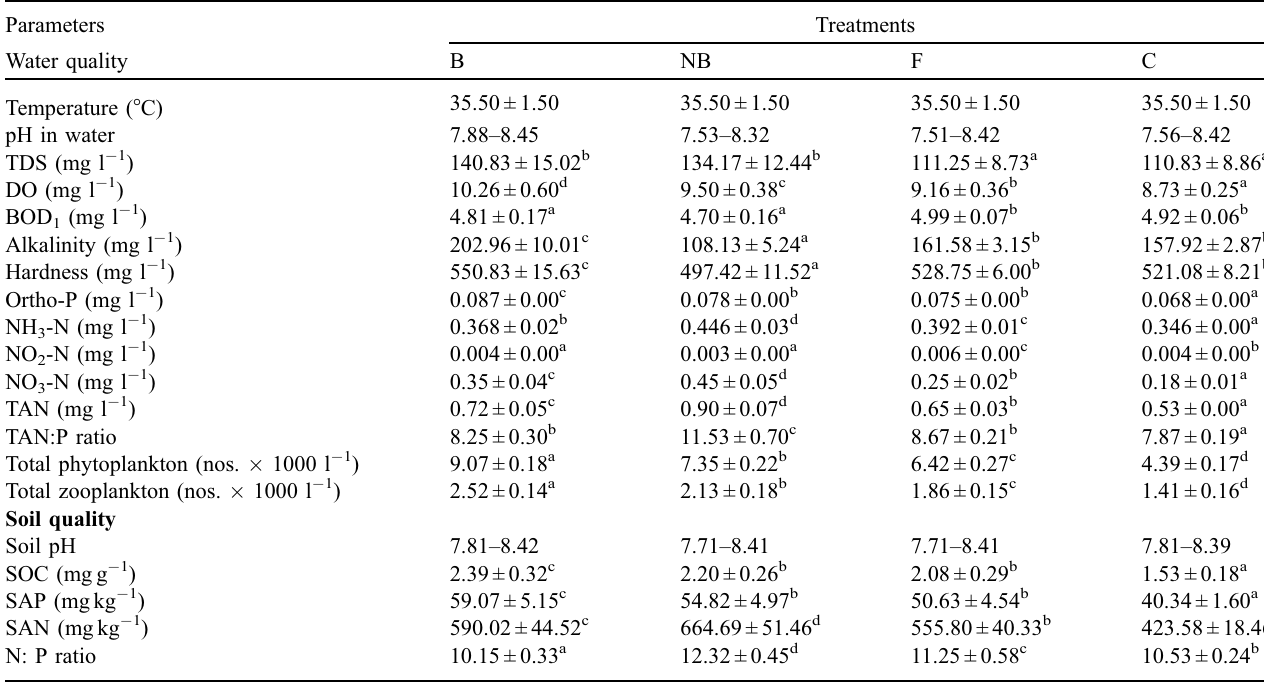
Table 6. Physico-chemical, biological and microbial parameters of water and soil in different pond treatments (mean ±standard error; n = 3).